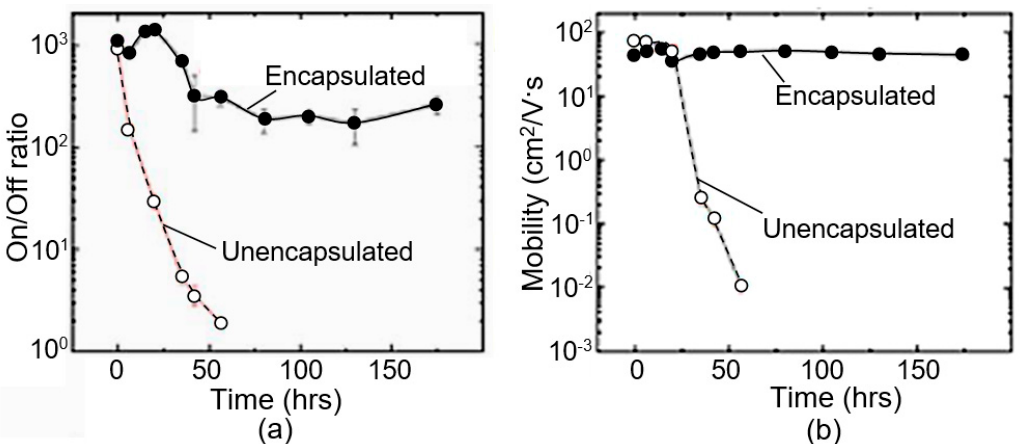
Figure 18. On/off ratio and the hole mobility of the black phosphorus field effect transistor for encapsulated one and unencapsulated one ( a , b ). Reproduced with permission from Ref. [102]. Copyright American Chemical Society,